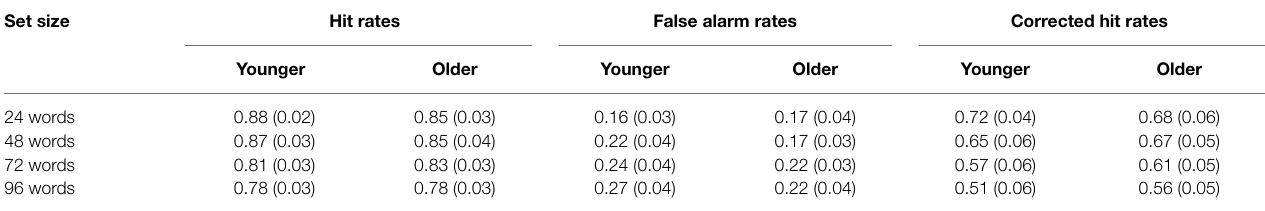
TABLE 1 | Accuracy for the recognition memory task.